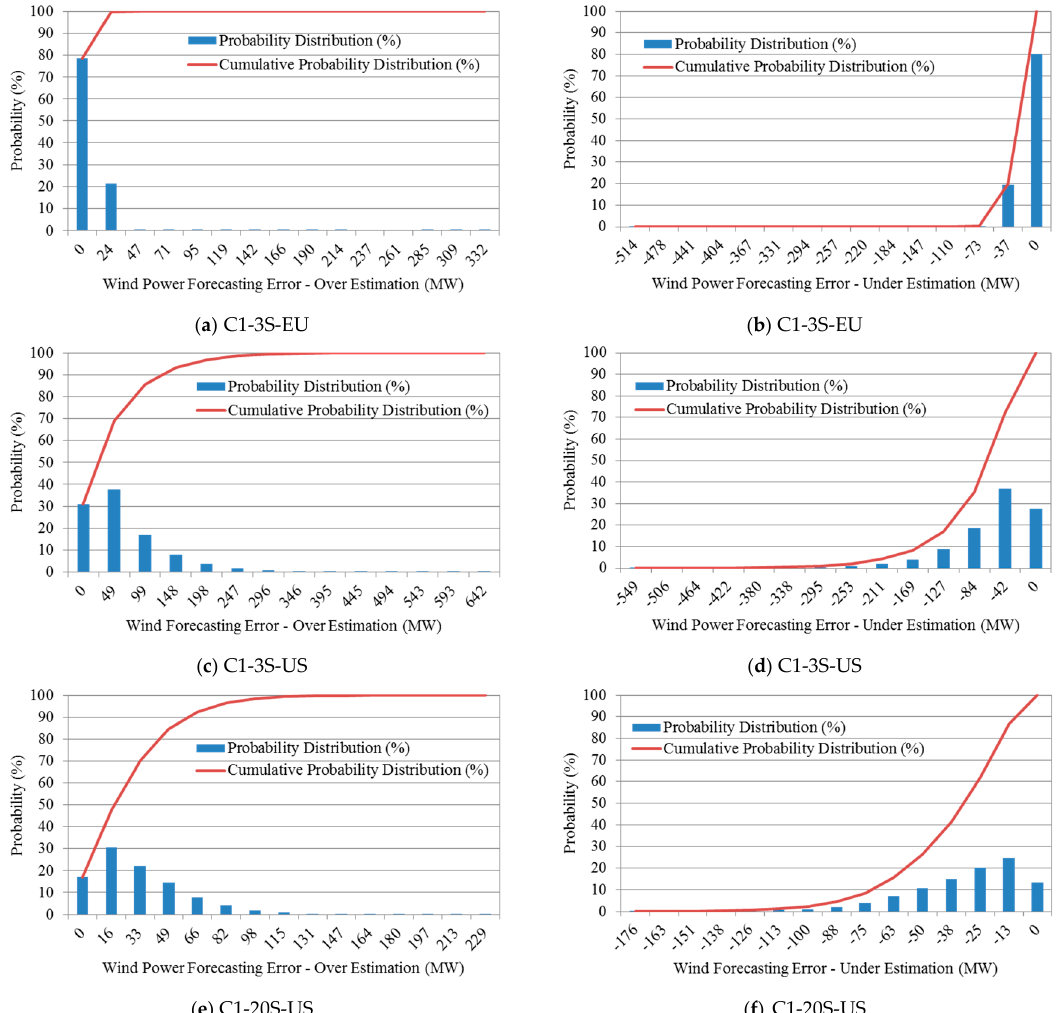
Figure 3. Probability distribution function of wind power forecasting errors.